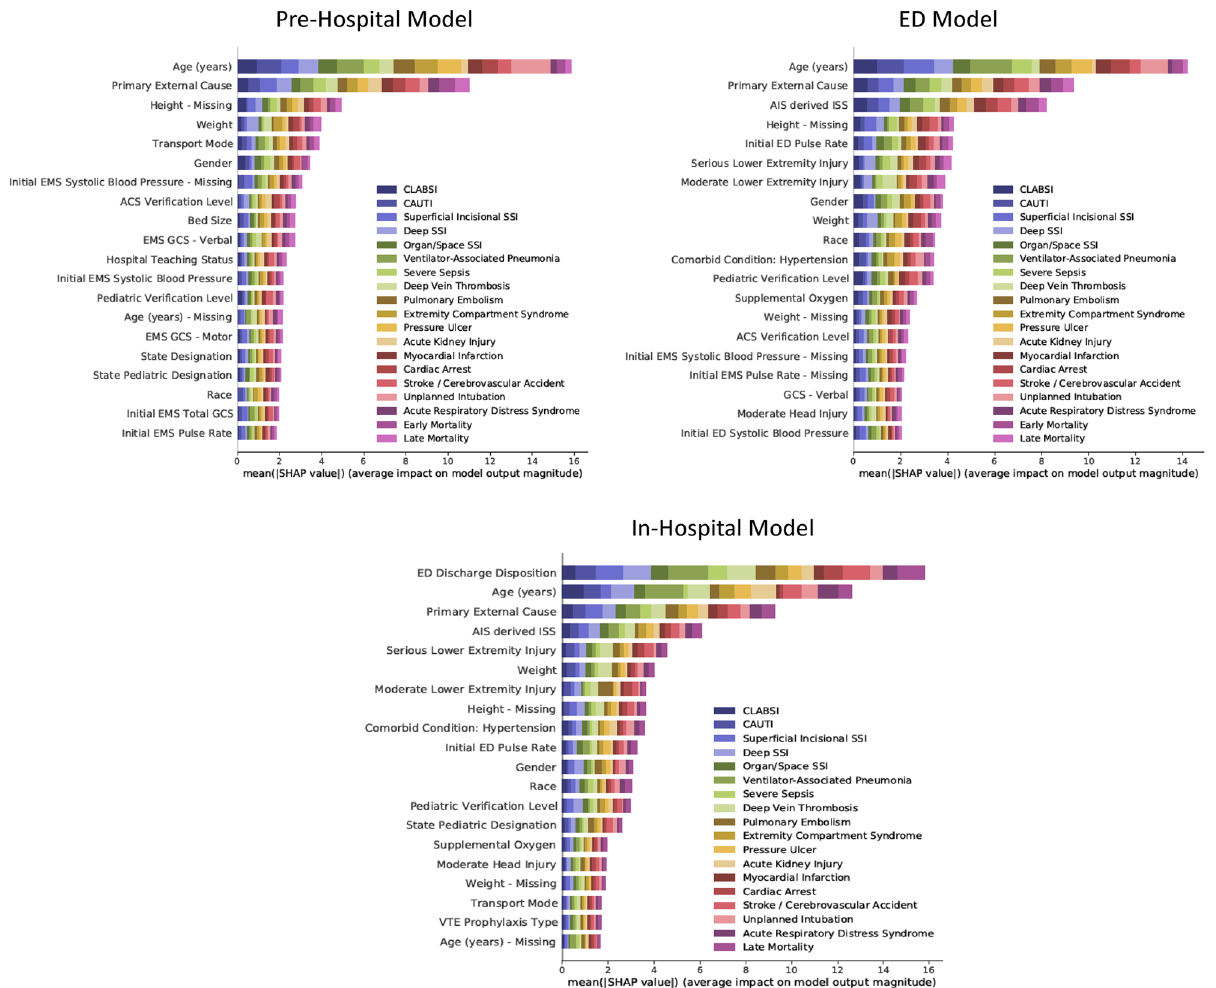
Figure 5. The permutation importance for the top 20 most important input features for each of the three models. The values on the x-axis indicate the average impact on model output magnitude based on Shapley Additive Explanations (SHAP). The features on the y-axis are arranged so that the input features with the largest average impact on model output magnitude are placed in the top. The horizontal bars are color-coded to match the output variables. The larger the colored area the more impact the model has on the corresponding. CLABSI Central line-associated bloodstream infection, CAUTI Catheter-associated urinary tract infection, SSI Surgical site infection, Early Mortality Mortality within the first day of hospitalization, Late Mortality Mortality after the first day of hospitalization, EMS Emergency Medical Services, ACS American College of Surgeons, GCS Glasgow Coma Scale, AIS Abbreviated Injury Scale, ISS Injury Severity Score, ED Emergency Department, VTE Venous thromboembolism, na Other machine learning projects have found mixed results for the risk stratification of trauma patients. These include studies on severe sepsis and septic shock (random forest classifier, ROC AUC = 0.88) 20 , pulmonary emboli (random forest classifier, ROC AUC = 0.71) 21 , acute respiratory distress syndrome (L2-logistic regression, ROC AUC = 0.81) 20 and acute kidney injury (random forest classifier, ROC AUC = 0.84) 20 . Machine learning based